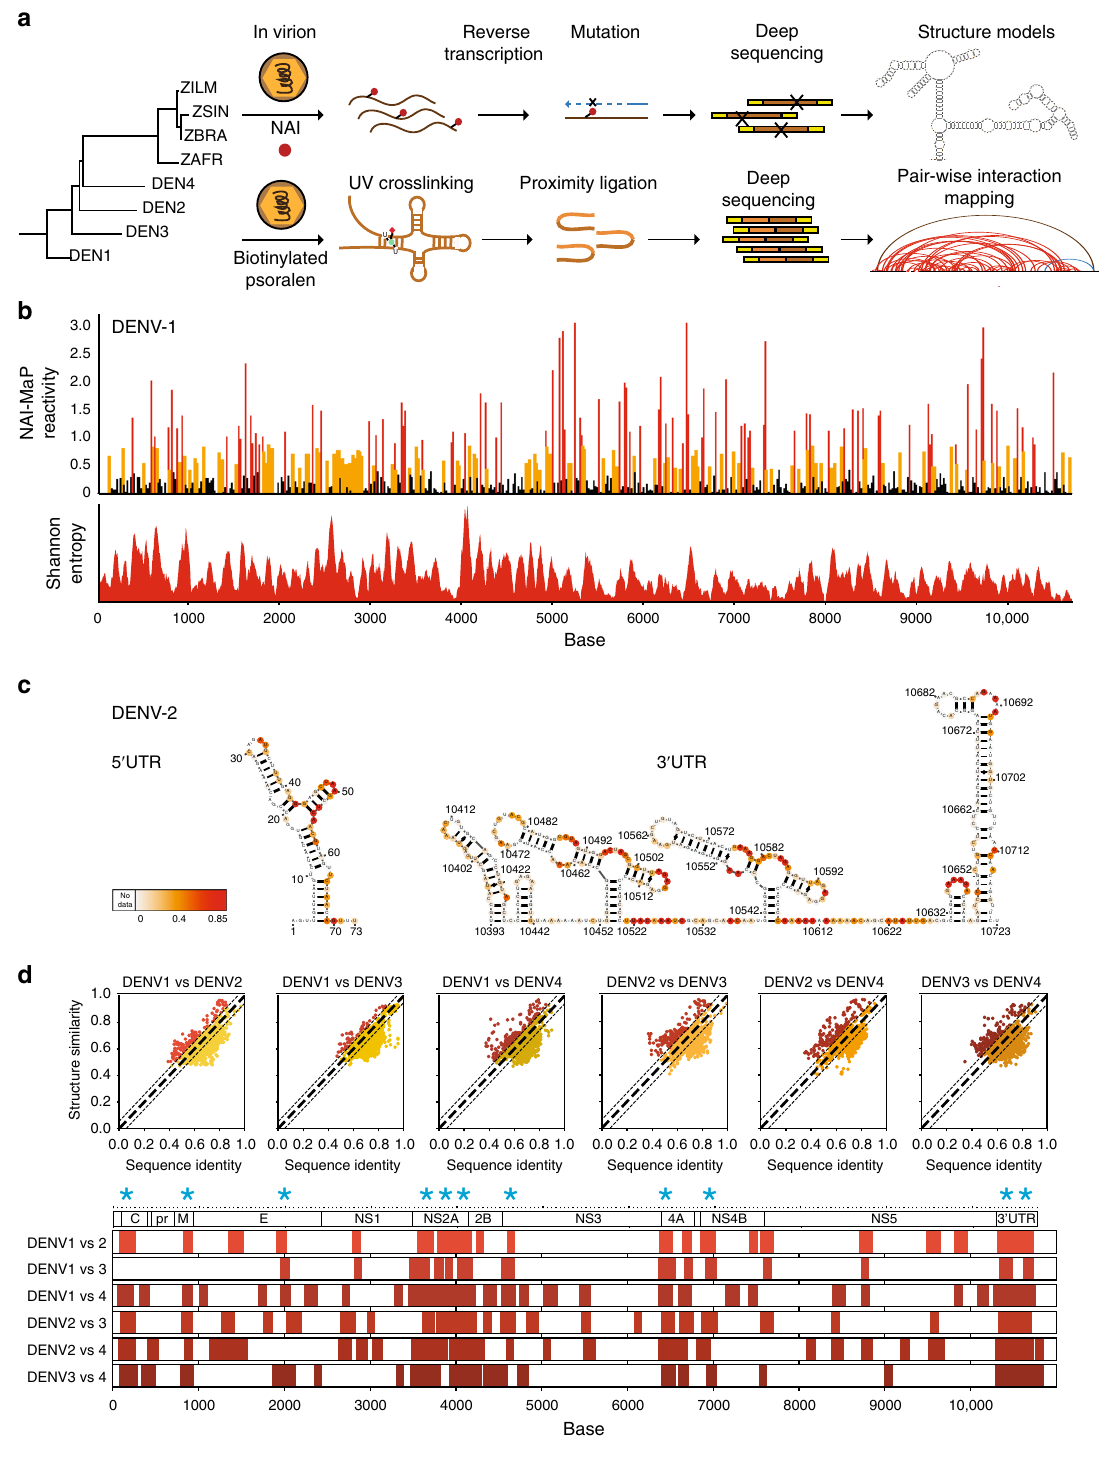
an accuracy of 91 and 87% (DENV1), 92 and 93% (DENV2), 78 and 86% (DENV3), 91 and 63% (DENV4), 76 and 73% (ZIKV African), 81 and 84% (ZIKV Brazil), 78 and 78% (ZIKV French Polynesia), and 85 and 83% (ZIKV Singapore) for 5 ′ and 3 ′ UTR structures respectively (Supplementary Figure 7). We veri fi ed that incorporating NAI-MaP reactivities into structure modeling signi fi cantly improved the accuracy of the structure models using 16S and 23S rRNA (Supplementary Figure 8a, Methods). Structure models incorporating NAI-MaP data are enriched for NATURE COMMUNICATIONS| (2019) 10:1408